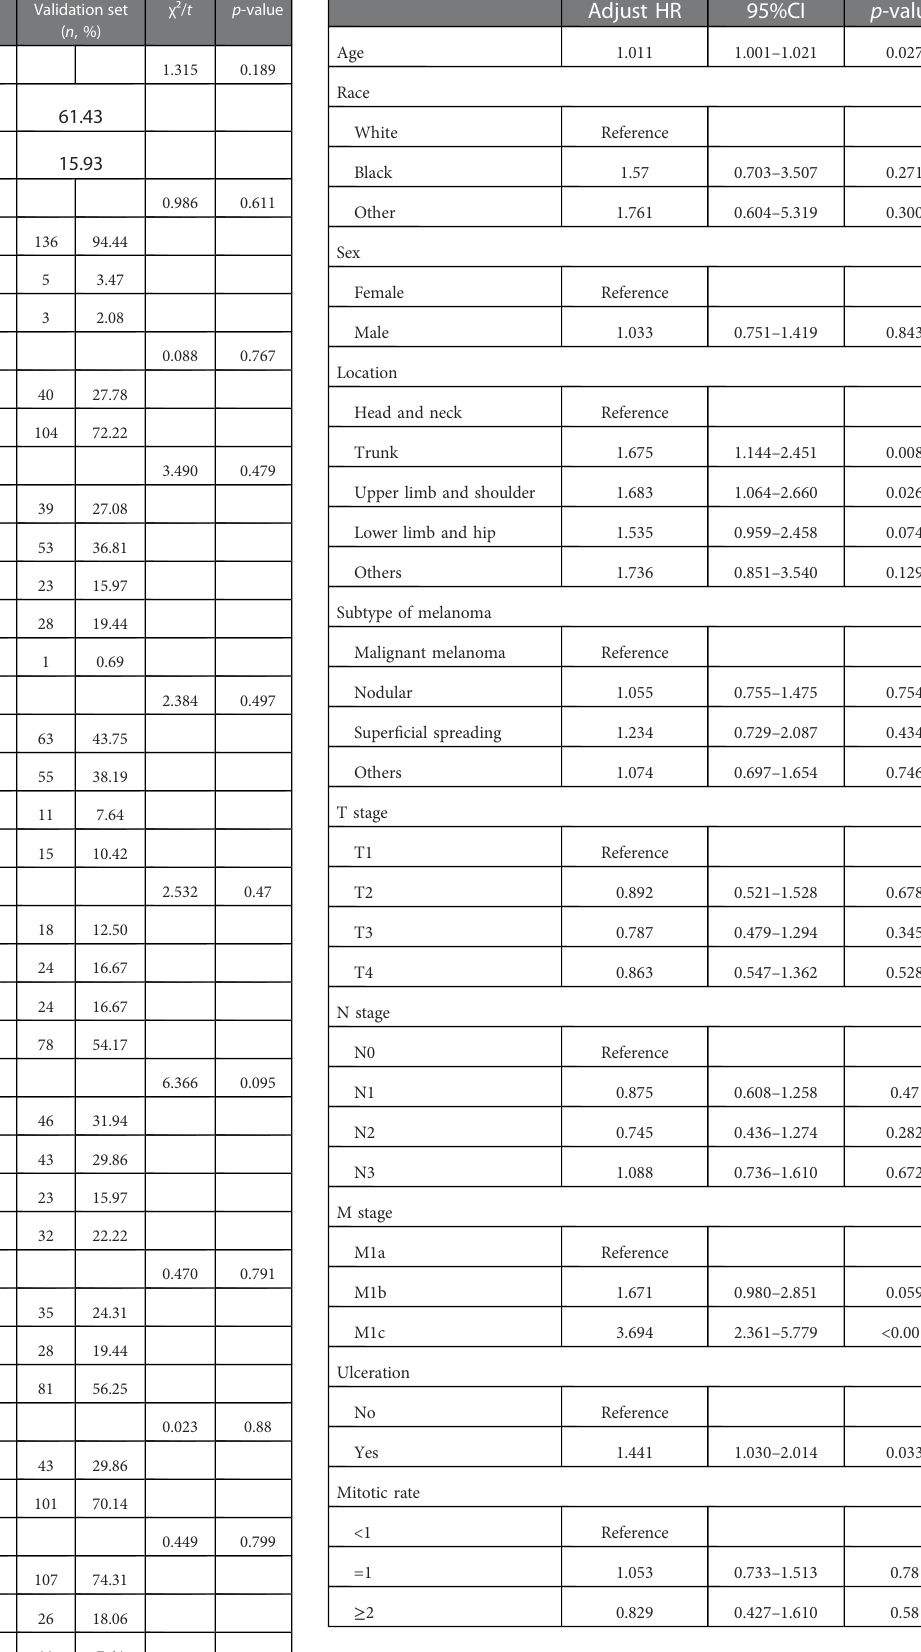
TABLE 3 Multivariate Cox analysis for CSS among population of surgery to primary